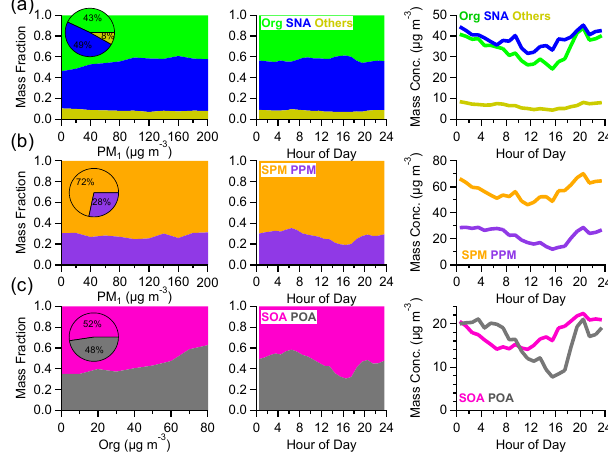
Figure 7. Left panels: variations in chemical composition of (a) or- ganics, SNA (i.e., sulfate + nitrate + ammonium), and others (the rest species in PM 1 ) , (b) SPM and PPM as a function of PM 1 , and (c) SOA and POA as a function of organics loadings, respectively. The middle and right panels show the diurnal profiles of composi- tion and mass concentrations,